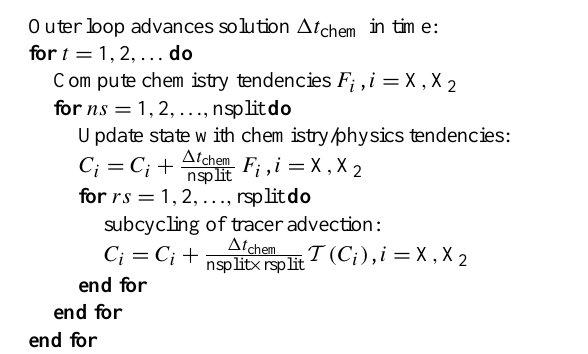
Algorithm 1 Pseudo-code explaining the different